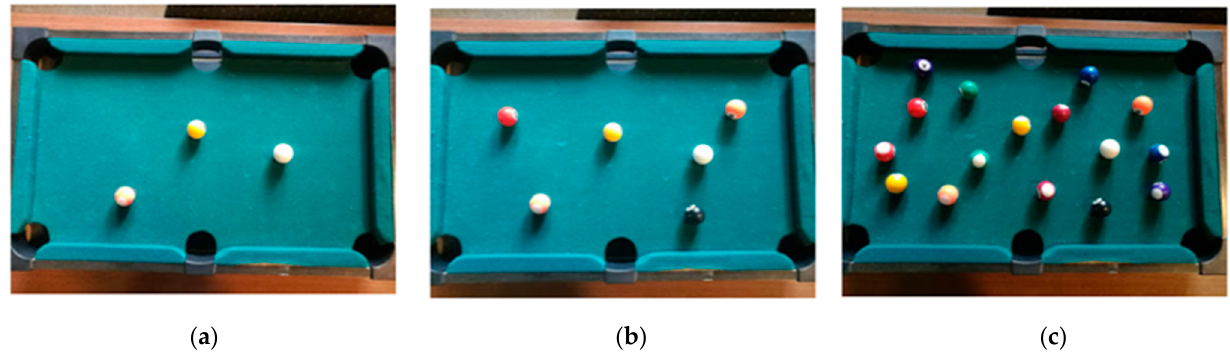
Figure 7. Different number of balls on the pool table to represent ( a ) low, ( b ) medium and ( c ) high population densities.